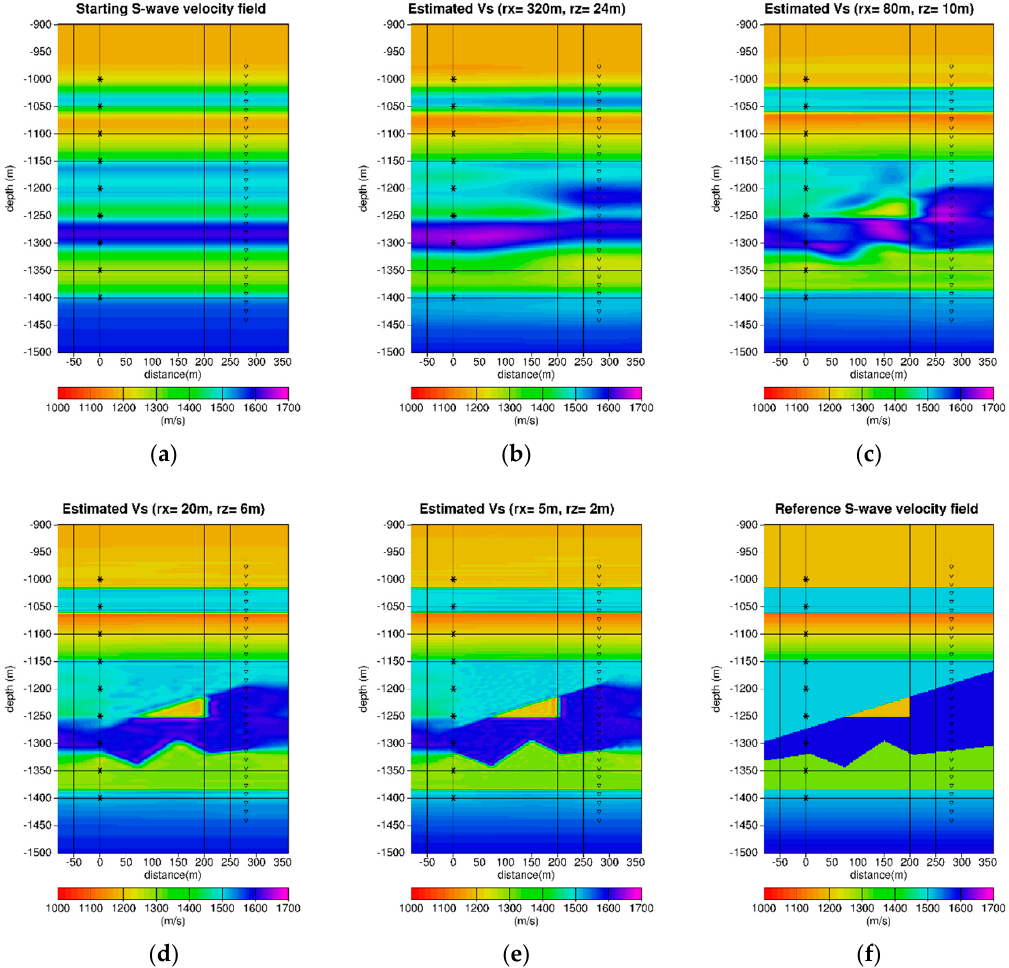
Figure 7. The results of the multiscale inversion process for the S-wave velocity field. Stars denote the source location while the small triangles denote the receiver location: ( a ) The S-wave velocity starting model; ( b ) the estimated S-velocity field obtained from the first inversion scale using correlation ranges of r x = 320 m and r z = 24 m in the 2D region; ( c ) the estimated S-velocity field obtained from the second inversion scale using correlation ranges of r x = 80 m and r z = 10 m in the 2D region; ( d ) the estimated S-velocity field obtained from the third inversion scale using correlation ranges of r x = 20 m and r z = 6 m in the 2D region; ( e ) the estimated S-velocity field obtained from the fourth and last inversion scale using correlation ranges of r x = 5 m and r z = 2 m in the 2D region; ( f ) the reference S-wave velocity model. The S-wave estimated field exhibits a better spatial resolution than the P-wave (see Figure 6) due to the smaller wavelength content associated with this mode. Small artifacts can be observed around the 2D triangle structure, pointing out the fact that the problem is less constrained in this part of the model.